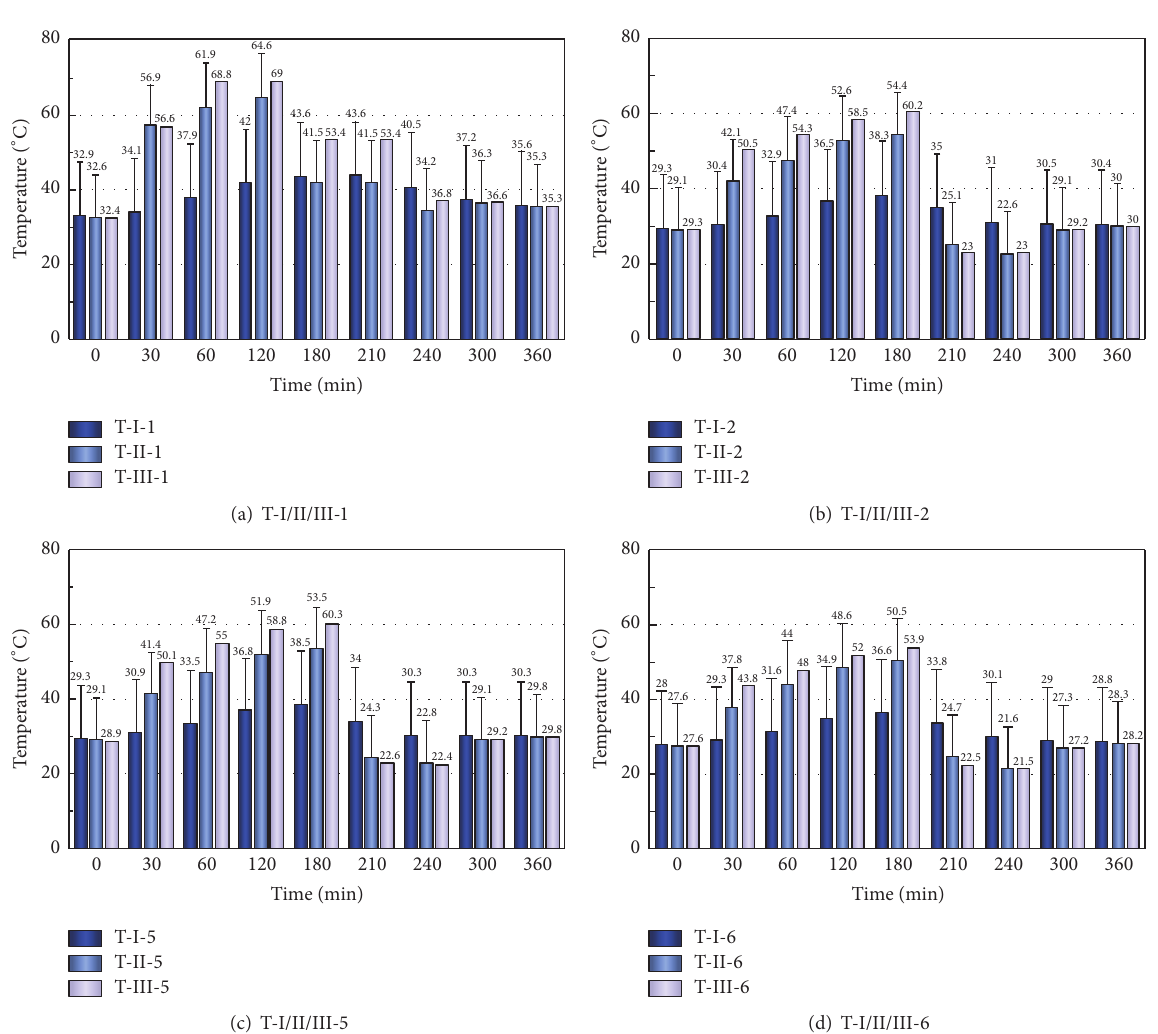
Figure 8: Temperatures at various instants for different measuring points along the direction of wall